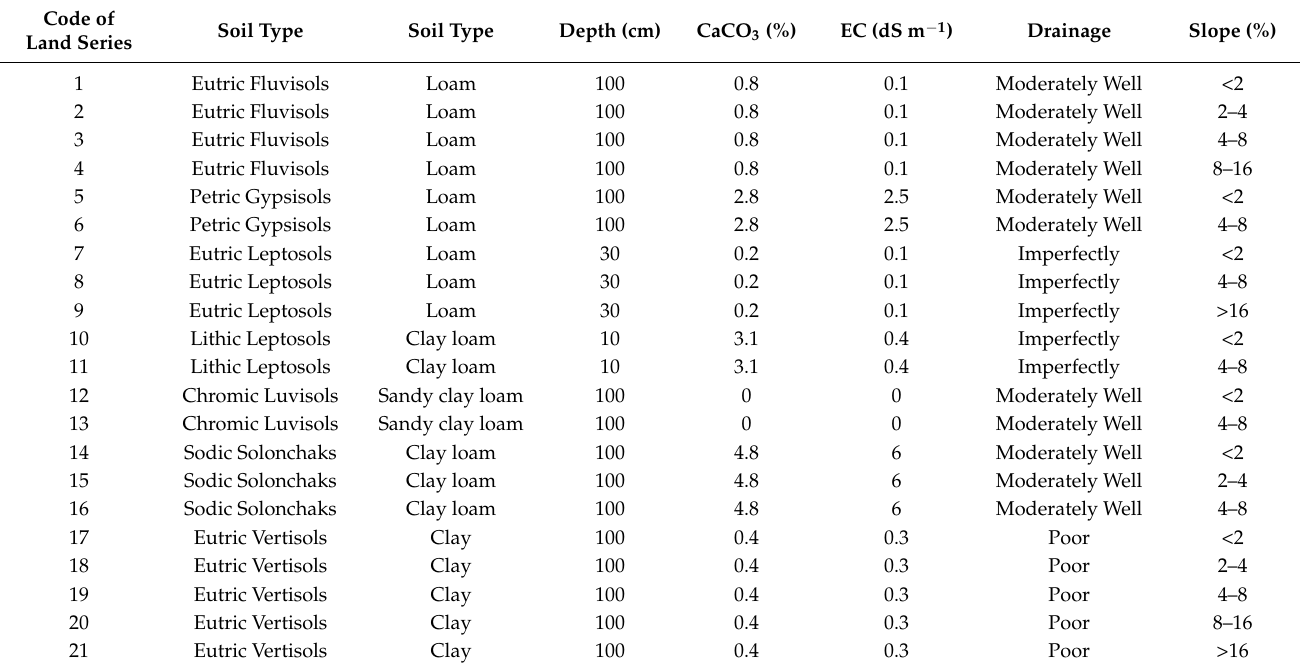
Table 3. The study area’s soil physicochemical